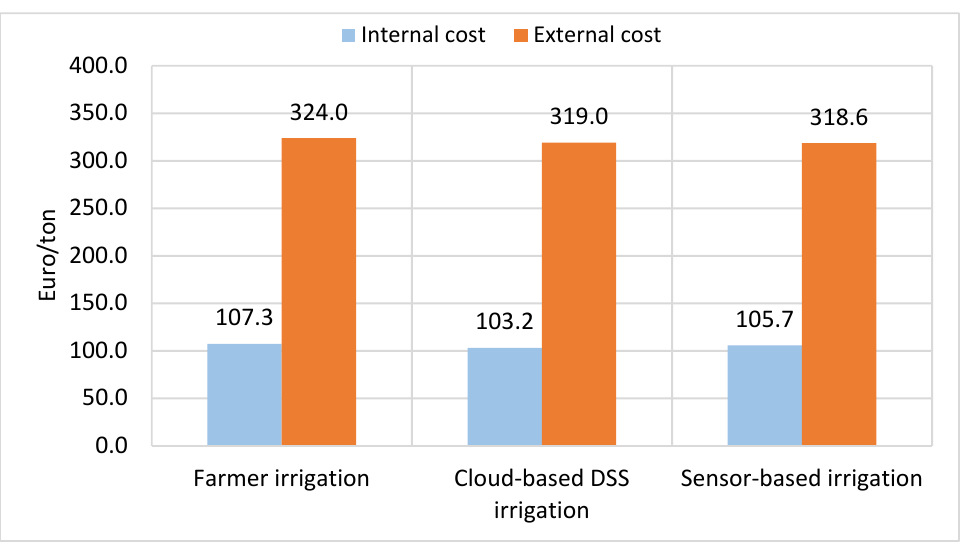
Figure 6. Life cycle cost of zucchini cultivation under different irrigation management strategies.